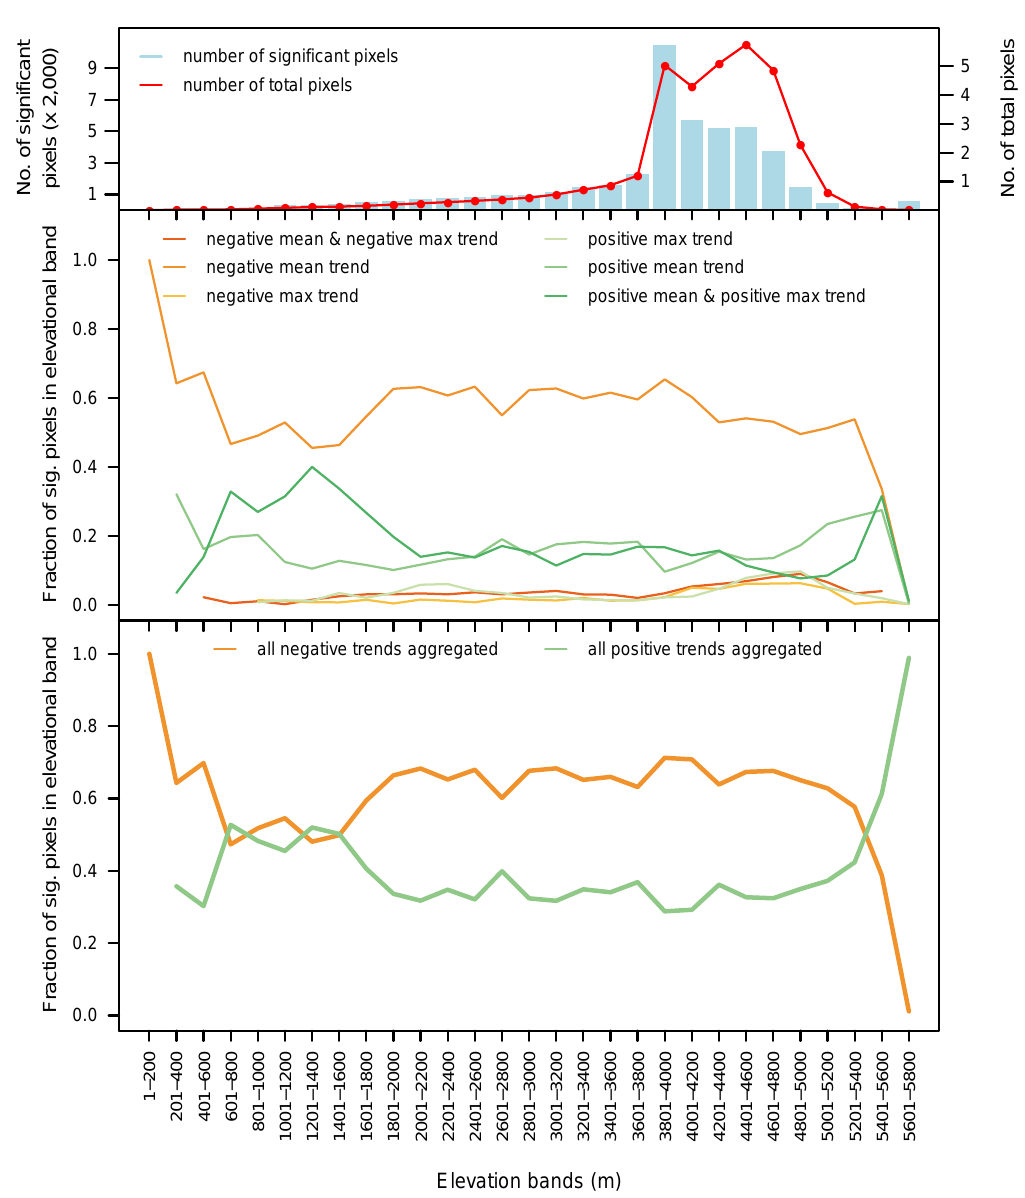
Figure 7. Greening and browning trends in the Andean Highlands by elevation. Most pixels are between 4200 and 5200 m and are browning. Above 5200 m, ecological succession in post-glacial landscapes is a greening process. Refer to the caption in Figure 5 for panel